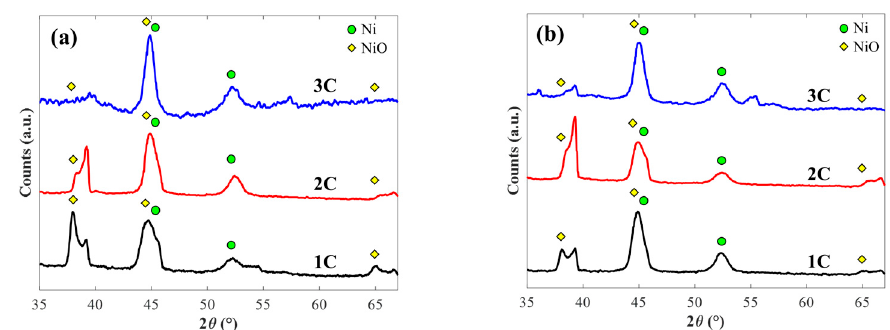
Figure 3. XRD measurements by grazing incidence for all samples as a function of the electrical charge for ( a ) potentiostatic and ( b ) galvanostatic electrodeposition.